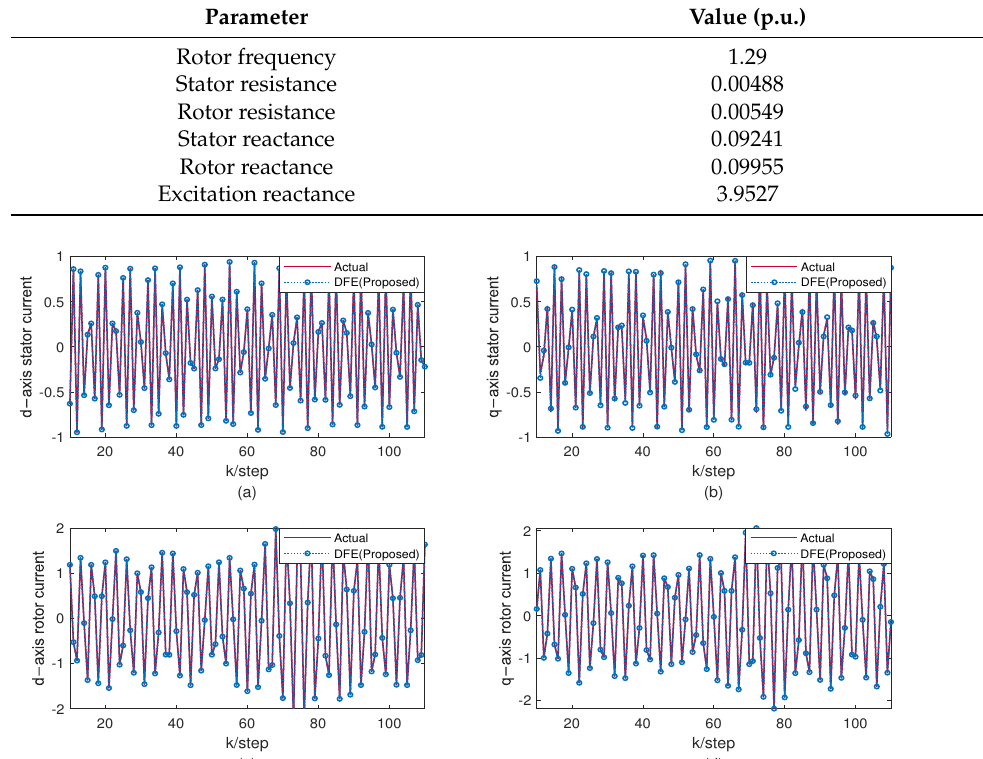
Figure 2. The trajectories of x ( k ) and ˆ x F ( k ) . ( a ) d-axis stator current estimation trajectories. ( b ) q-axis stator current estimation trajectories. ( c ) d-axis rotor current estimation trajectories. ( d ) q-axis rotor current estimation trajectories.